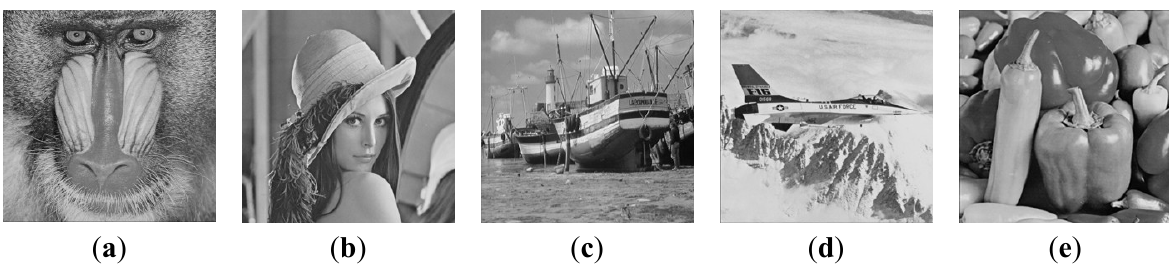
Figure 3. Images used for simulation experiments ( a ) Baboon. ( b ) Lena. ( c ) Boat. ( d ) Plane. ( e ) Peppers.